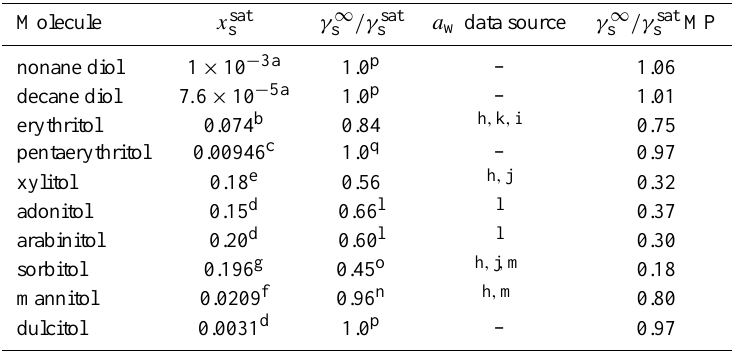
Table 4. Mole fraction solubilities x sat s and activity coefficient ratios γ ∞ s /γ sat s derived from a w data. Estimations of γ ∞ s /γ sat s by UNIFAC- MP are also